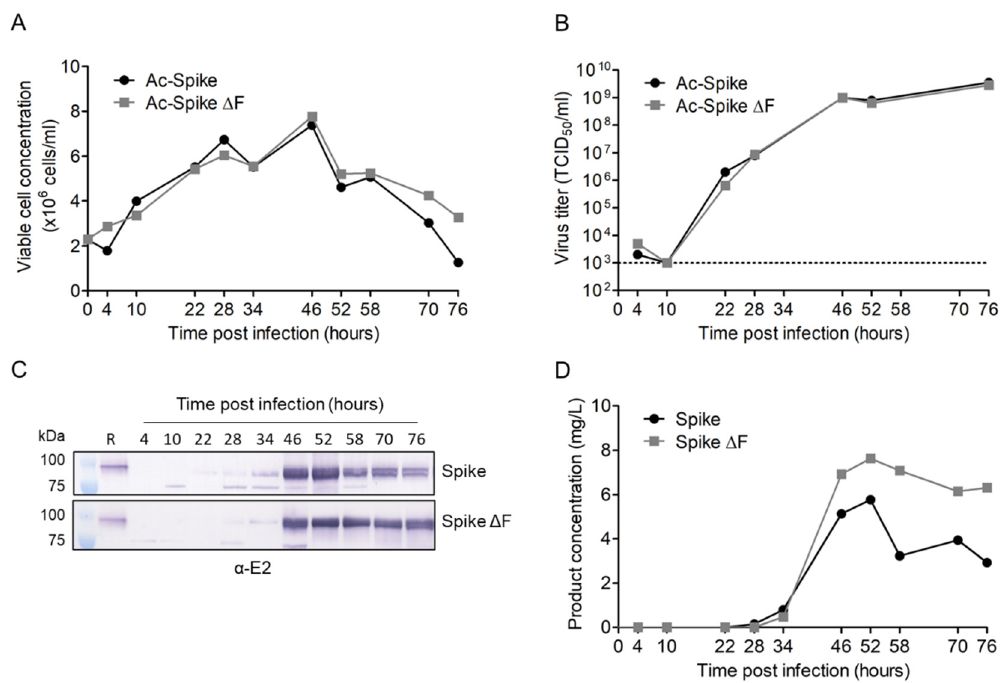
Figure 4. Spike and spike Δ F production in suspension insect cells. The Sf9 suspension cells were infected with Ac-Spike and Ac-Spike Δ F at a cell concentration of 2 × 10 6 cells/mL and MOI of 0.01 TCID 50 /cell in 200 mL shake flasks. Samples were taken at various time points to evaluate ( A ) the viable cell concentration by hemocytometer cell count with trypan blue staining, ( B ) recombinant baculovirus titers by end-point dilution assay (threshold indicated by dotted line), and ( D ) spike and spike Δ F product concentrations quantified by ( C ) relative expression to purified CHIKV E3E2 subunit reference sample (R) on an α -E2 Western blot.